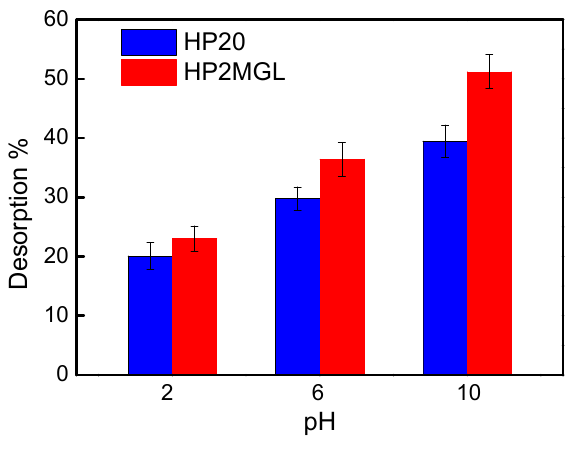
Figure 10. Desorption of SDBS from adsorbents in ultrapure water (10 mL) at various pHs (2, 6, and 10) at 25 °C. [adsorbents] = 5 mg/mL.